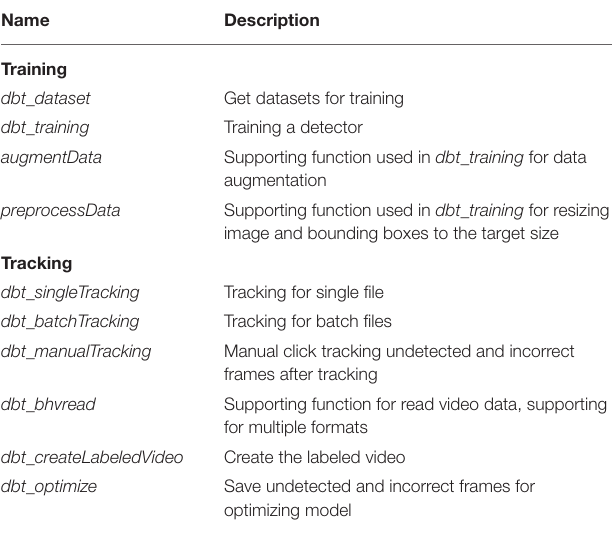
TABLE 1 | Detailed list of codes related to